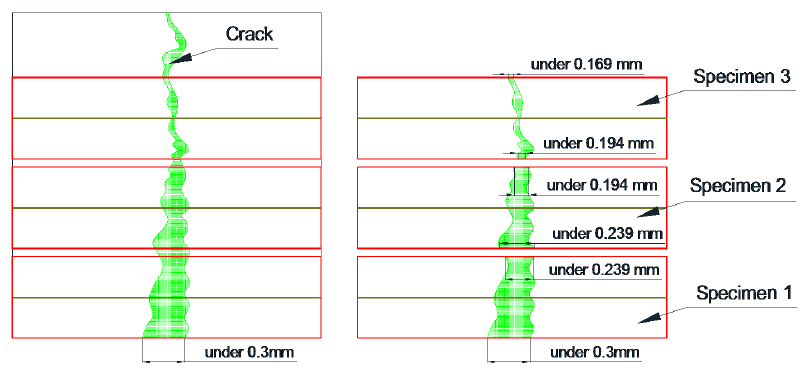
Figure 3. Conceptual diagrams of the crack distribution and widths of the specimen by measuring microscope.